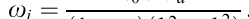
Table 1. E-region and field parameters during the ROSE F4 flight Parameter